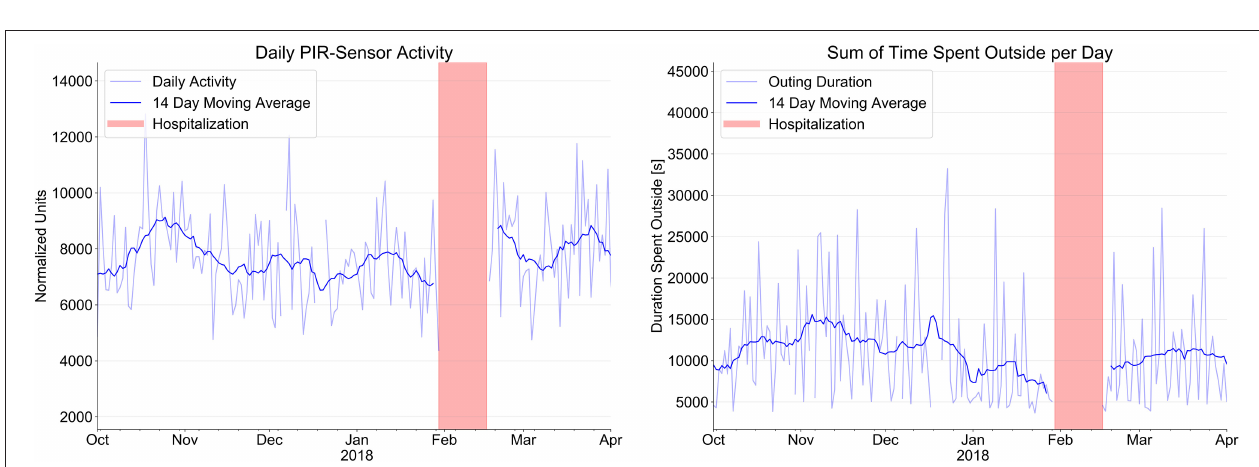
Our results indicate a great potential of home monitoring signals provided by a non-obtrusive ambient sensor system for the detection of early signs of heart failure